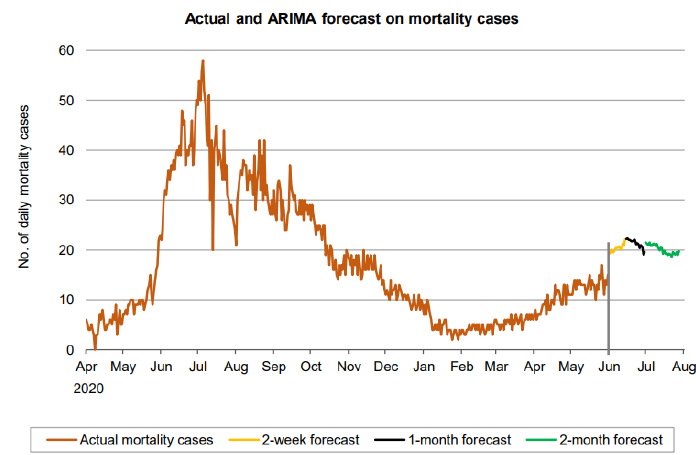
Figure 13. Prediction over a 60-day forecast for the death cases using the ARIMA model.